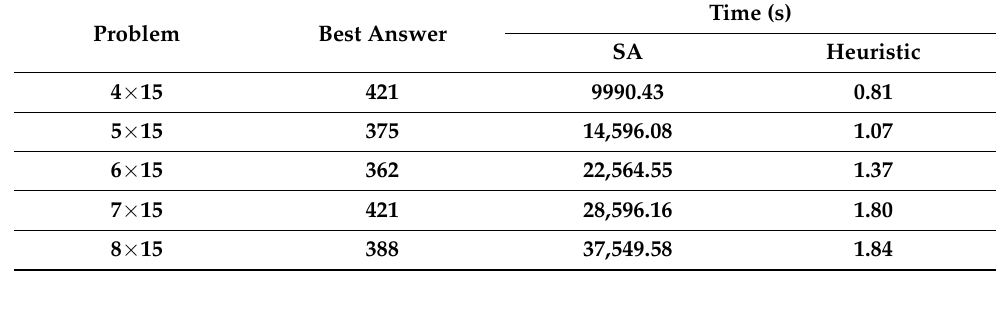
Table 2. Results of executing the SA and heuristic algorithms on various test data (15 ORs). Problem